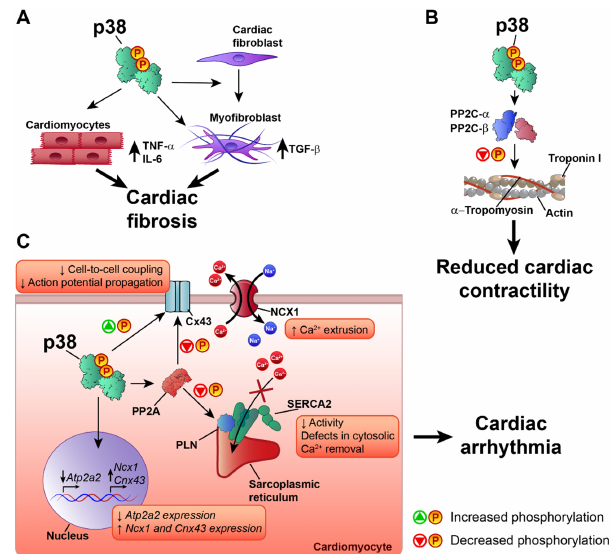
Figure 3. p38 in heart failure and cardiac arrhythmia. p38 activation participates in the development of heart failure and cardiac arrhythmia through three main mechanisms: (A) Increased cardiac fibrosis by induction of TNF- α and IL-6 in cardiomyocytes, differentiation of fibroblasts, and induction of TGF- β in cardiac myofibroblasts; (B) Reduced cardiac contractility due to dephosphorylation of a- tropomyosin and troponin I via PP2C- α /PP2C- β ; (C) Promotion of cardiac arrhythmias due to reduced expression and activity of SERCA2 ( Atp2a2 ), increased expression of NCX1 ( Ncx1 ) and Cx43 ( Cnx43 ), and altered Cx43 phosphorylation, inducing cardiac contractile dysfunction and altered action potential propagation. ↑ increase, ↓ decrease.